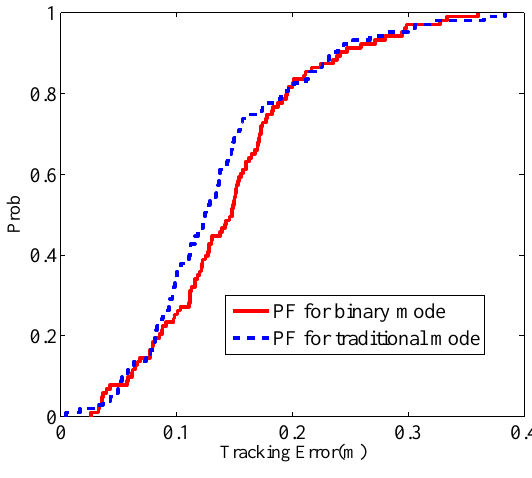
Figure 13. CDF of localization